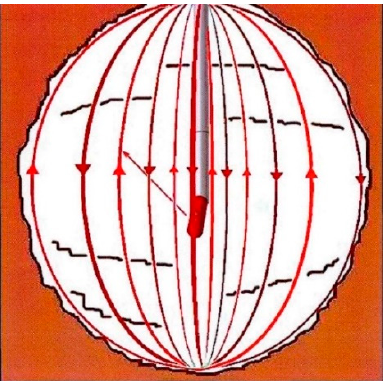
Figure 5. Vertical scanning mode.